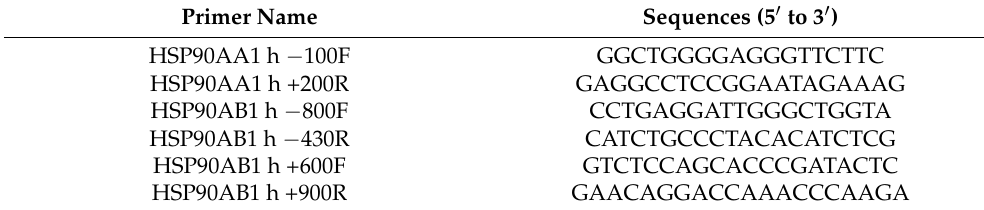
Table 8. Primer sequences for